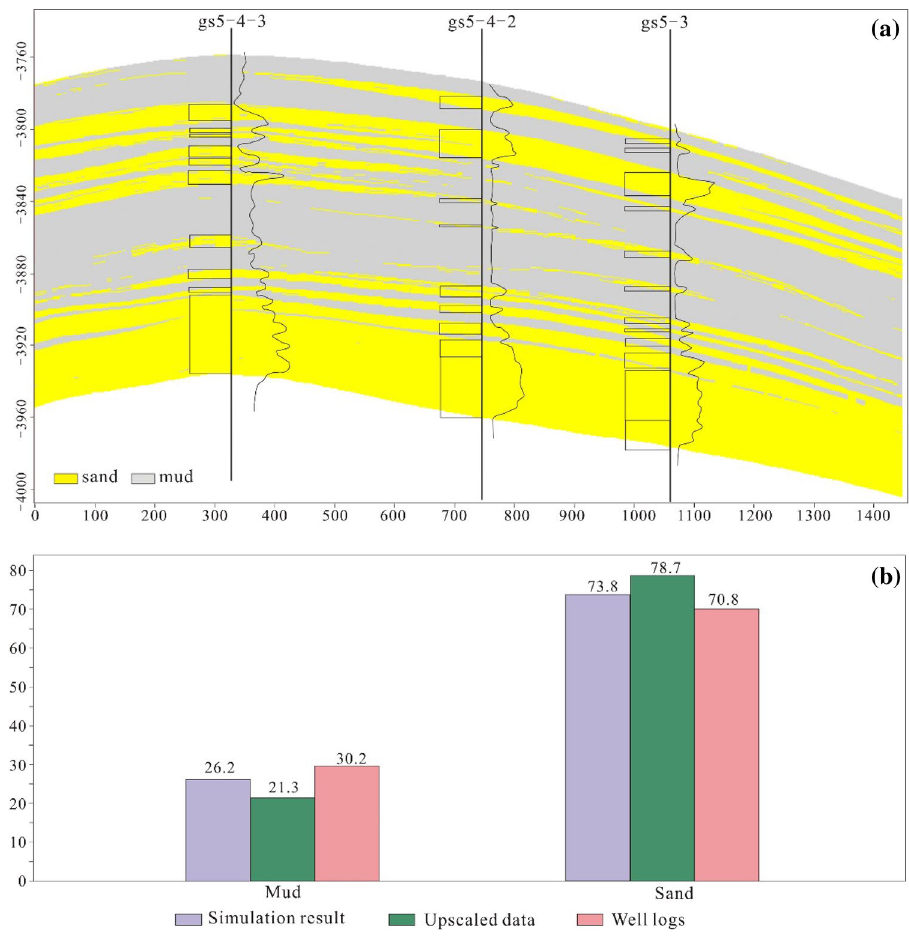
Fig. 6 Vertical section and qual- ity control of facies model and t in Maxi Oilfield. a Vertical section of facies model in Well gs5-4-3, gs5-4-2 and gs5-3. b Relationship of well logs, upscaled data and simulation